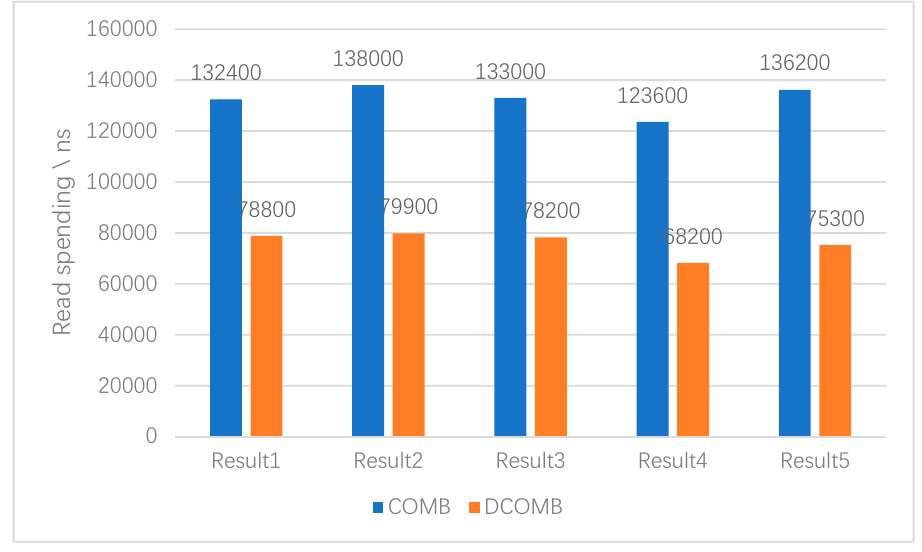
Figure 11. Random read time-consuming.